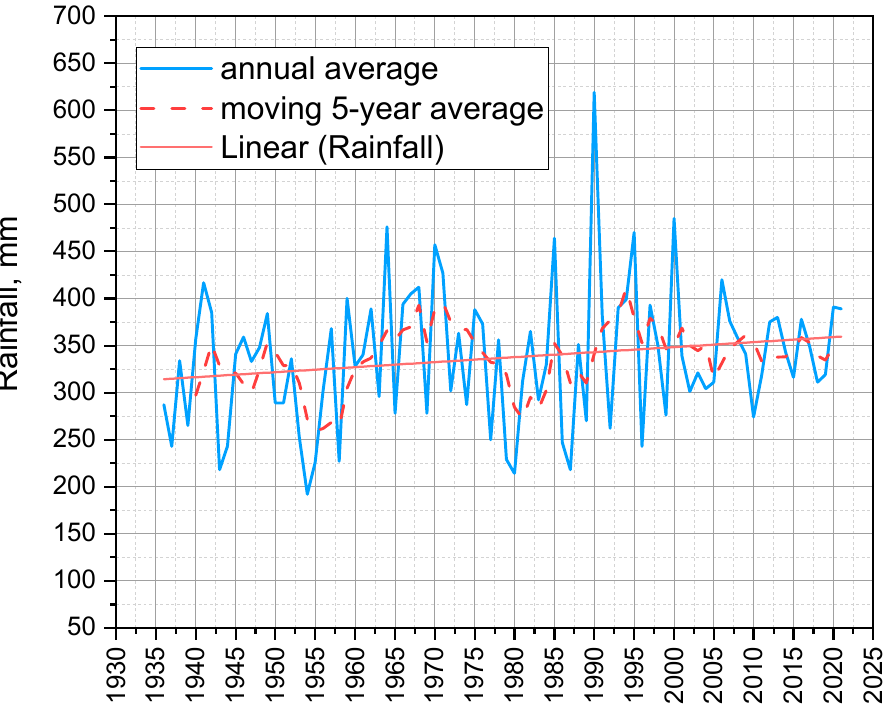
3.121 Table 2. SS and MK test results for the Kyakhta station. Variable (Month)